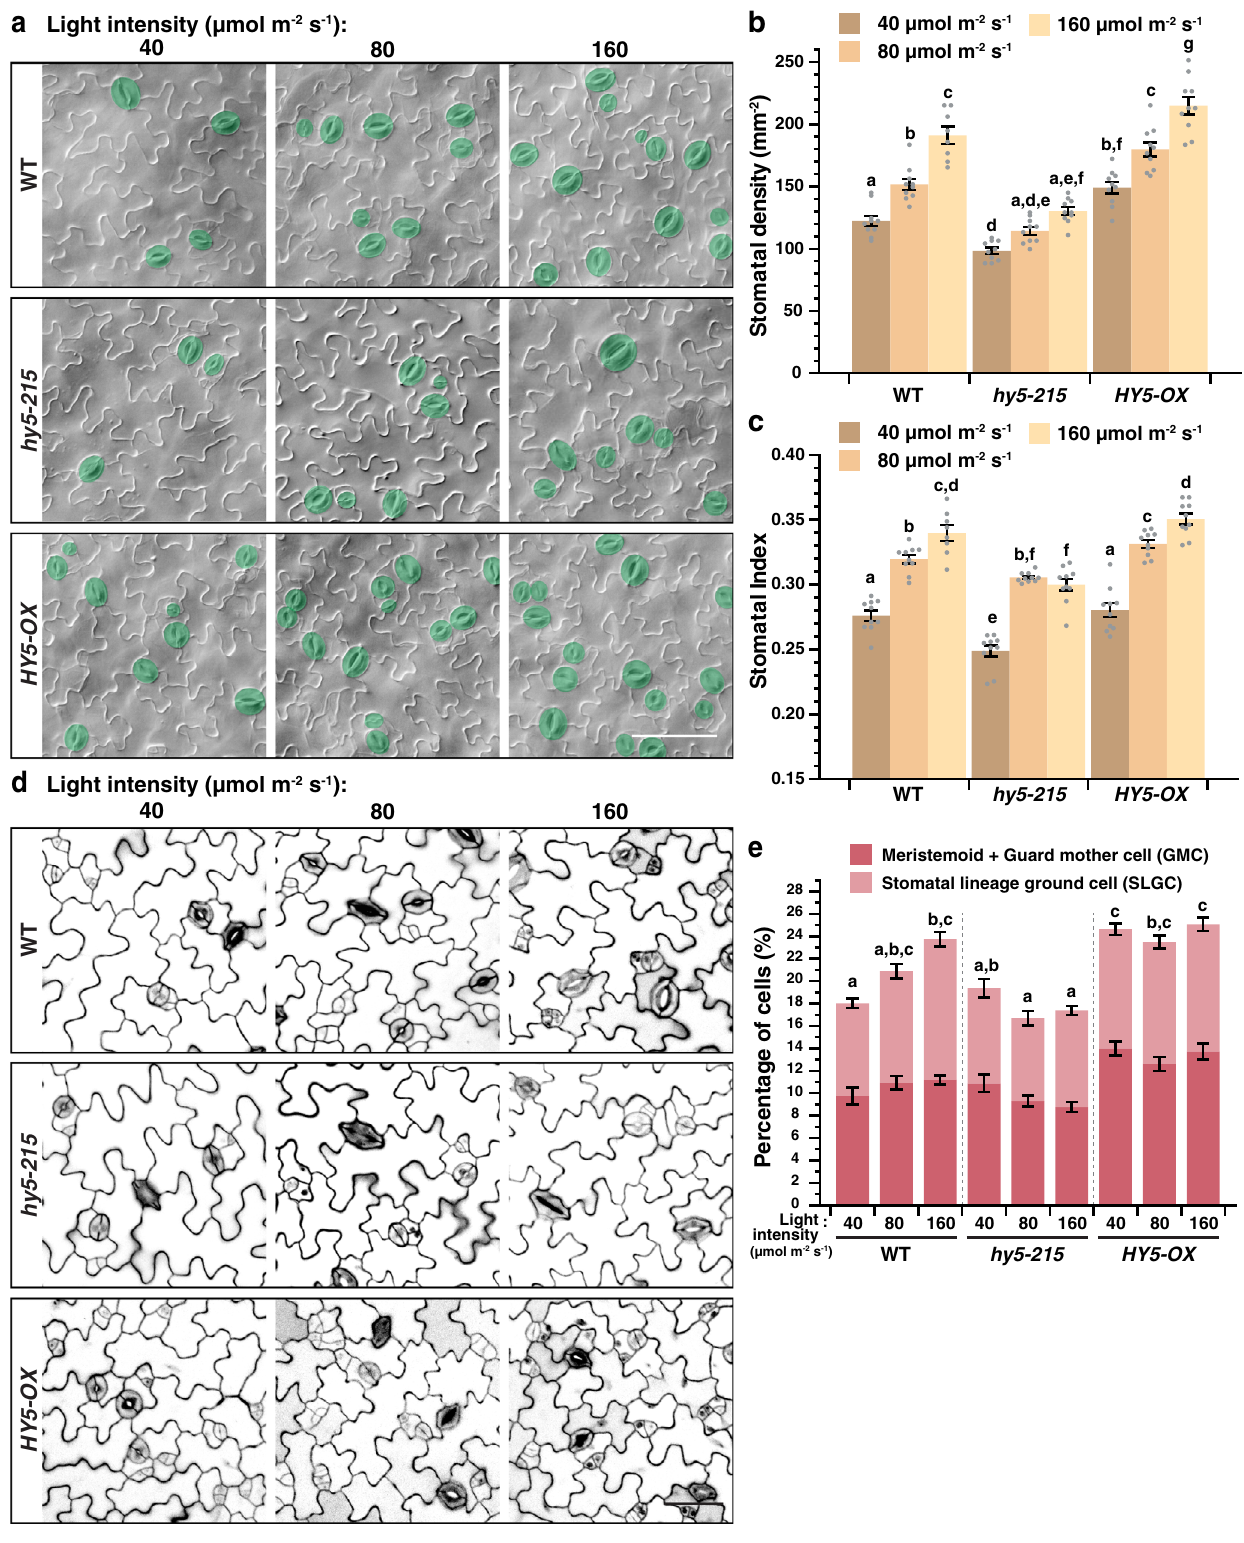
Fig. 1 HY5 is required for the light regulation of stomatal development. a – c Changes in stomatal production in response to light intensities in WT, hy5- 215 , and HY5-OX (overexpression line of HY5 ). Arabidopsis seedlings were grown for 10 days at 22 °C under three distinct light intensities (40, 80, and 160 µ mol m − 2 s − 1 ). Representative images ( a ), stomatal densities ( b ), and stomatal indices ( c ; see text) of the abaxial cotyledons are shown. Stomata are pseudo-colored in green ( a ). Scale bar, 80 μ m. d , e Seedlings of the above genotypes ( a ) were grown for 3 days to capture the early cell types of the stomatal lineage under the three light intensities ( a ). Representative confocal images ( d ) and the percentage of these early cell types, which include meristemoids, guard mother cells (GMCs) and stomatal lineage ground cells (SLGCs) ( e ; see text and “ Methods ” ) of the abaxial cotyledons are shown. Scale bar, 40 μ m. b , c , e Values are mean + / − SEM, n = 10 independent cotyledons. Two-way ANOVA with Tukey ’ s multiple comparisons test, P <